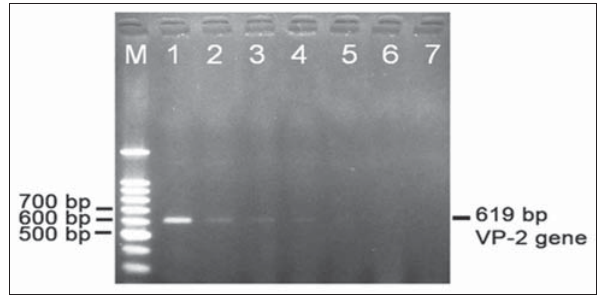
Figure-2: The sensitivity of RT-PCR method for detecting VP-2 gene of avian encephalomyelitis virus using RNA template from serial dilution of sample code 499/4/12 in agarose gel 1.5%. Lane M is marker DNA Ladder, lane 1-7 are number of serial dilution of RNA template with the concentration 1=1022 ng/ μ l, 2=511 ng/ μ l, 3=255.5 ng/ μ l, 4=127.75 ng/ μ l, 5=63.5 ng/ μ l, 6=31.94 ng/ μ l, and 7=15.97 ng/ μ l respectively.